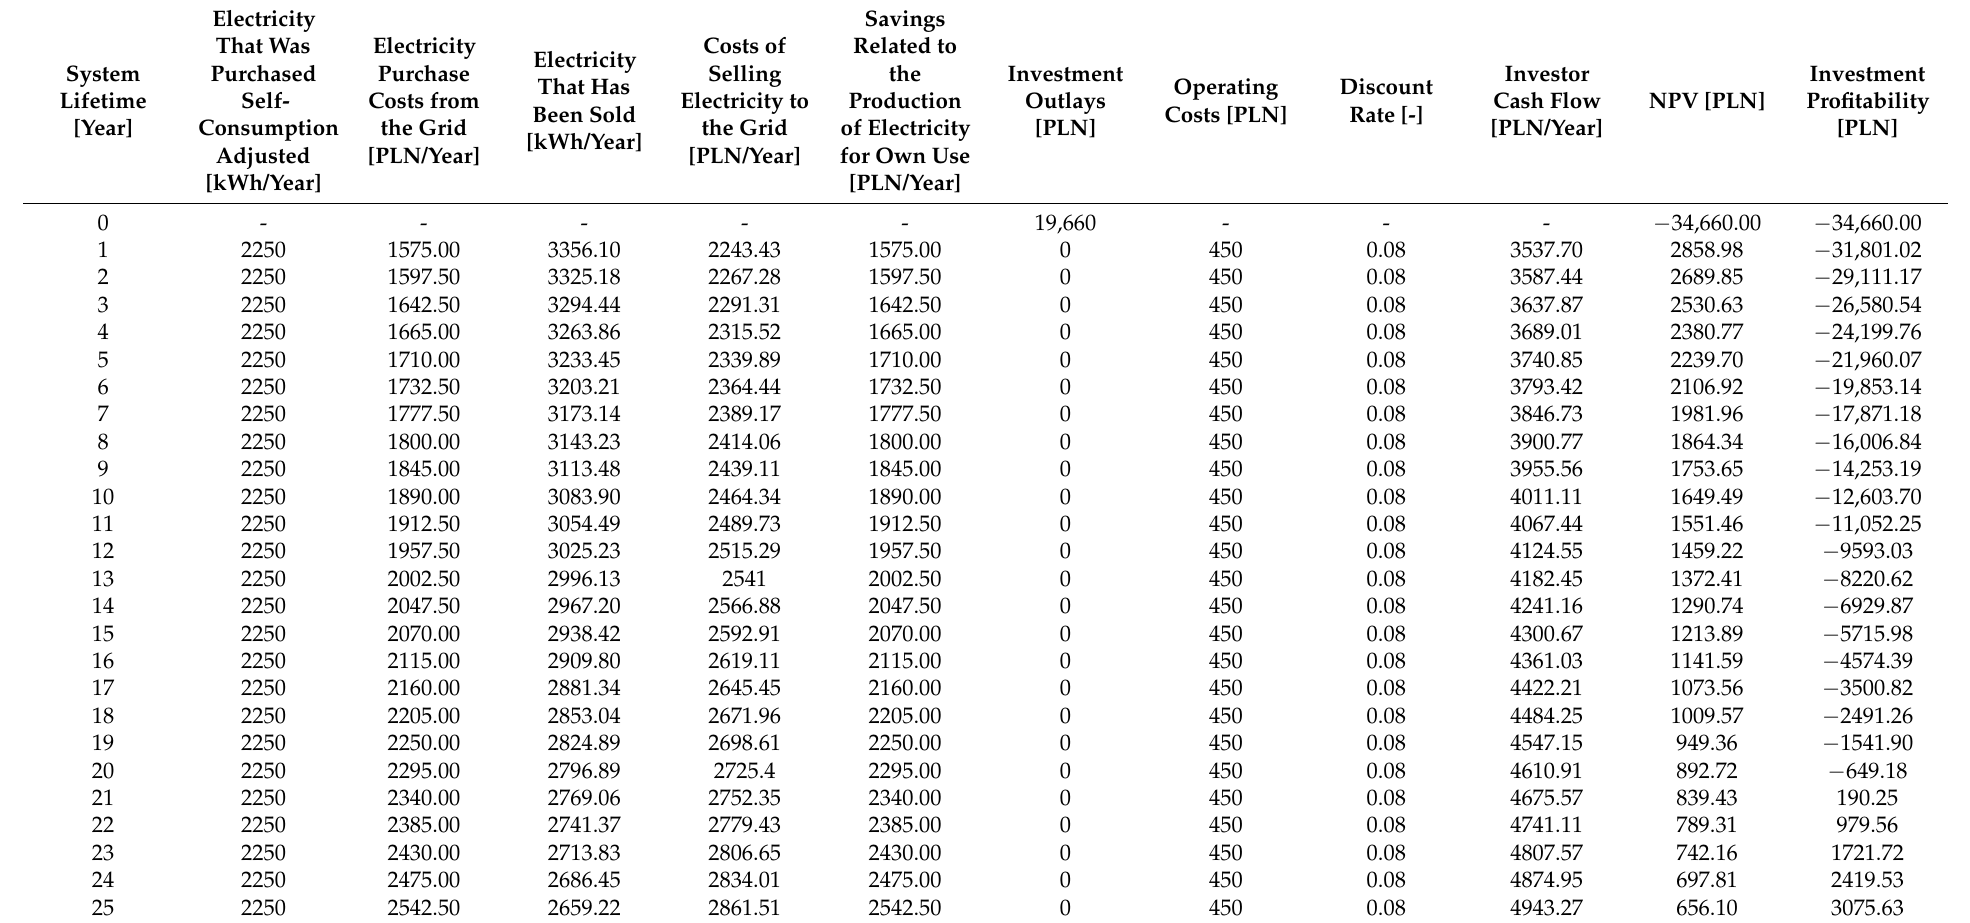
Table A7. NPV results of PV installation for the net-billing system based on hourly prices, at a 50% self-consumption level, with energy